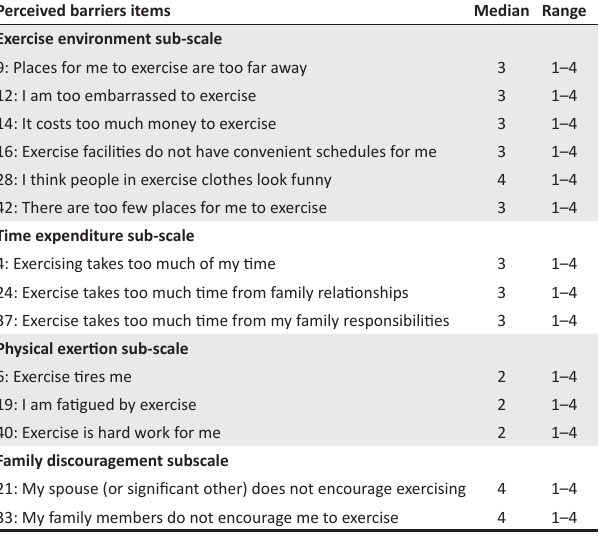
TABLE 3: The exercise barriers scale: Median and range of each questionnaire item.